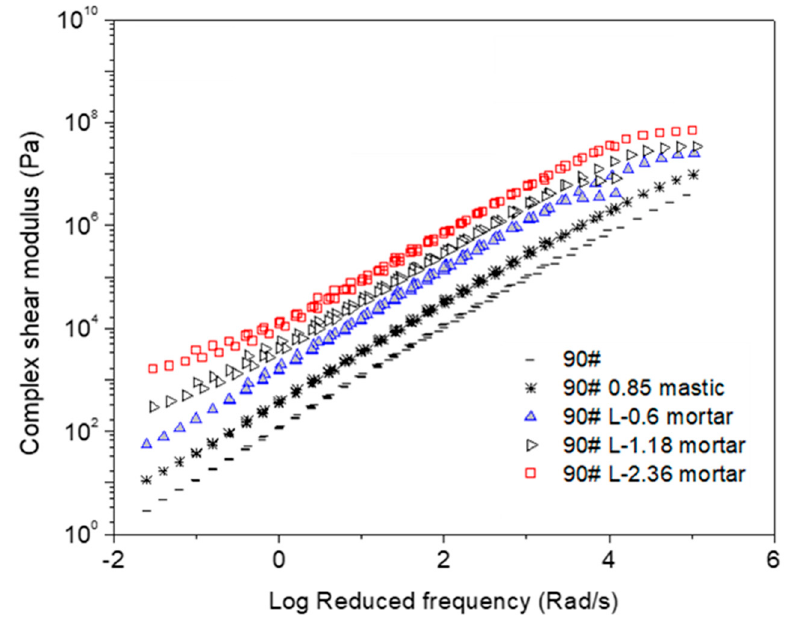
Figure 1. Complex modulus master curves of AC-25 based asphaltic materials including neat asphalt binder, mastic and mortar at a reference temperature of 60 °C.